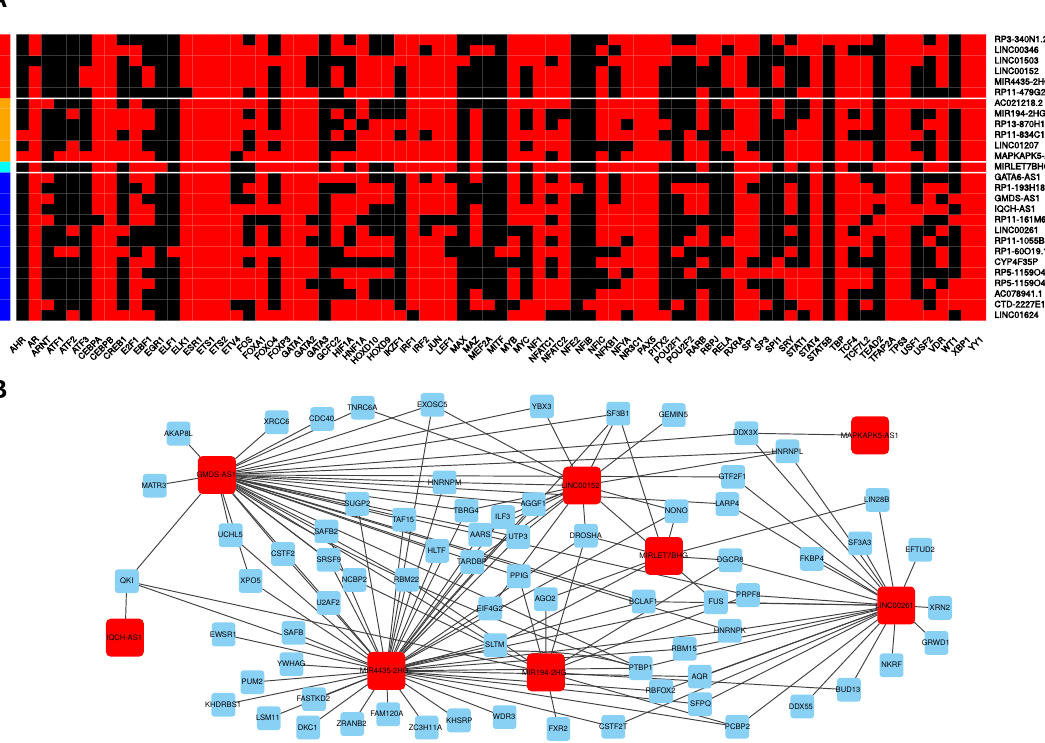
Figure 4. Putative transcriptional and post-transcriptional regulators of lincRNAs. ( A ) Transcription factors (TFs) predicted to bind to the promotor region ranging from 2000 bp upstream to 1000 bp downstream of the putative transcriptional start site (TSS) of the respective lincRNA. Red colour denotes a predicted TF binding. Row colour codes on the left side denote lincRNAs upregulated in both tumour subtypes compared to normal pancreas with significantly higher expression in the basal-like subtype (red); upregulated in both subtypes and significantly lower in the basal-like subtype (orange); downregulated in both subtypes and significantly higher in the basal-like subtype (cyan); downregulated in both subtypes and significantly lower in the basal-like subtype (blue). ( B ) Network representation of potential interactions between RNA-binding proteins (RBPs) and the selected candidate lincRNAs based on CLIP data. Red nodes represent lincRNAs, blue nodes RBPs. Edges are drawn, if significant CLIP sites were found for the respective lincRNA-RBP